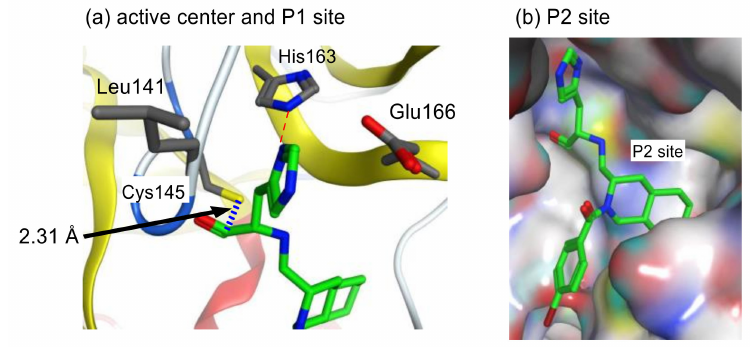
Figure 14. Interactions of inhibitor 42 at the active center ( a ) and P2 site ( b ) of SARS-CoV 3CL pro .